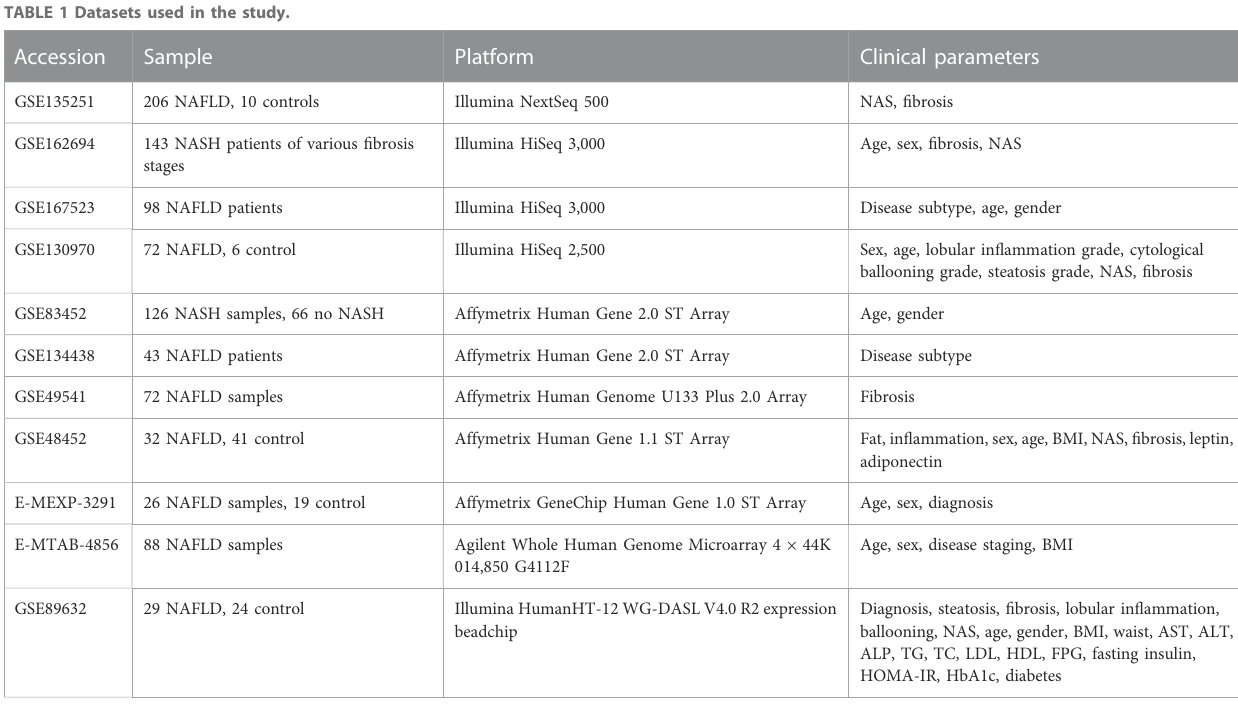
TABLE 1 Datasets used in the